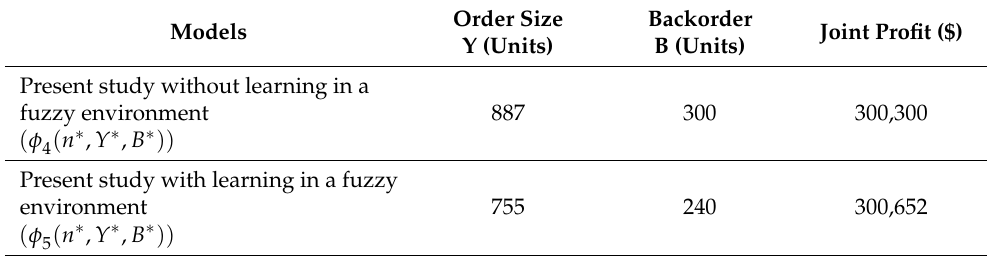
Table 3. Representation of the comparison with and without the learning effect.